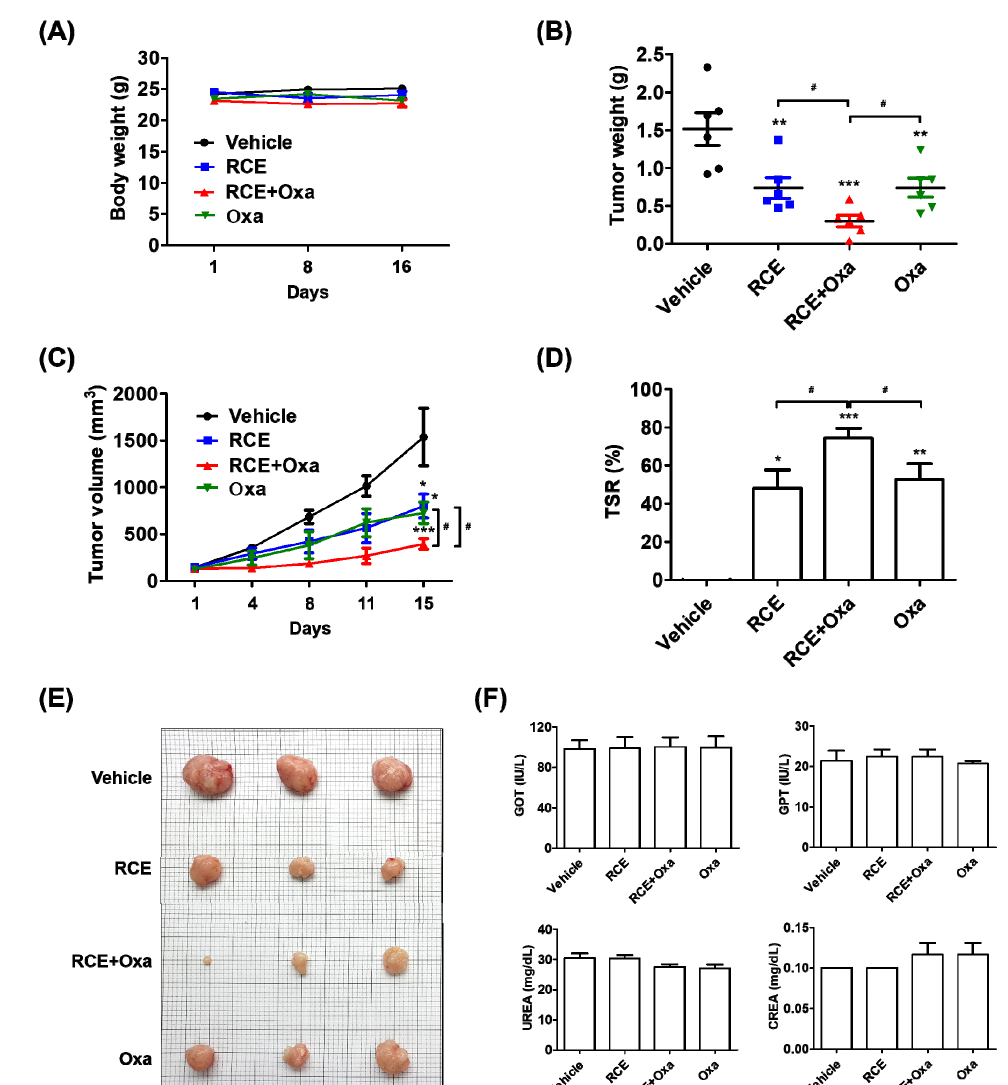
Figure 3. RCE plus Oxa reduced tumor growth in the human PD-1/PD-L1 MC38 tumor allograft mouse model. ( A ) Body weight (grams) on days 1, 8, and 16. ( B ) Tumor weight on day 16. ( C ) Tumor volume curves of hPD-L1 MC38 tumors in vehicle (PBS)-, RCE (100 mg/kg)-, RCE plus Oxa-, and Oxa (2.5 mg/kg)-treated groups on days 1, 4, 8, 11, and 15. ( D ) TSR% (Tumor suppression rate, %) on day 16. ( E ) Image of the stripped tumor tissues ( n = 3, bar indicates 1 cm). On day 16, the mice were euthanized and photographed after tumor tissue excision. ( F ) GOT, GPT, UREA, and CREA levels in human PD-1/PD-L1 MC38 tumor mouse serum. The results are presented as the mean ± SD. * p < 0.05, ** p < 0.01, and *** p < 0.001 compared with the vehicle group, # p < 0.05 compared to the individual group.